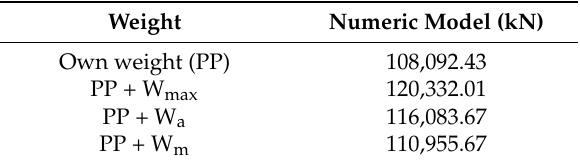
Table 4. Weights obtained from the numerical